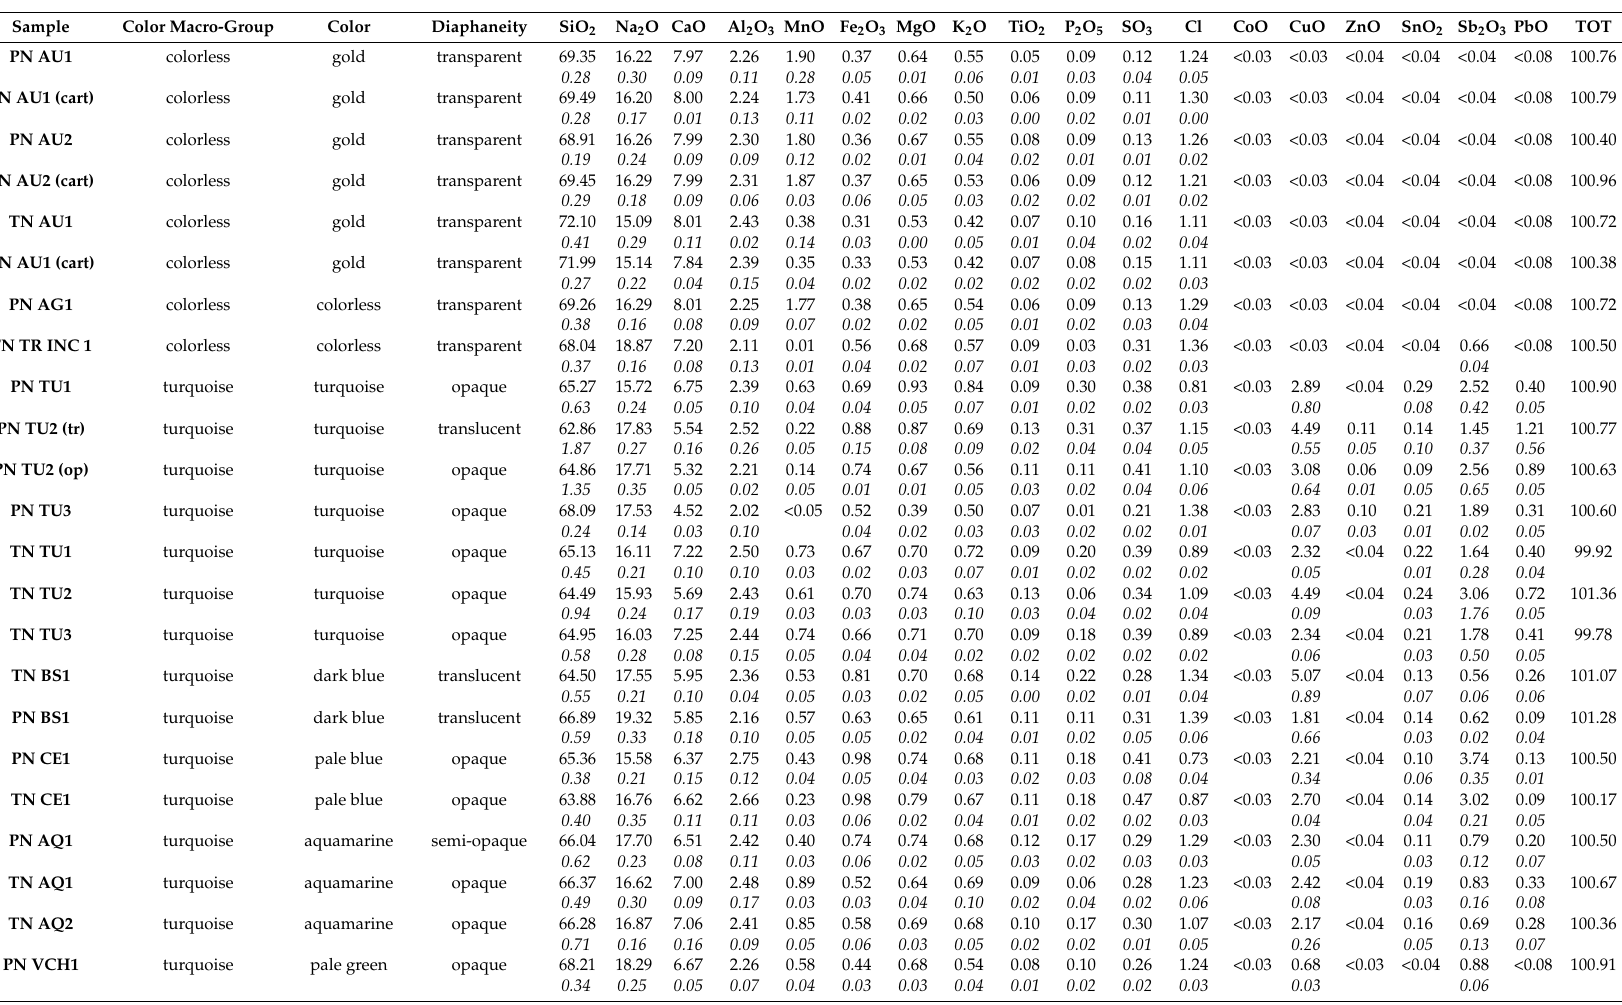
Table 2. The mean chemical compositions of the glass tesserae (EPMA data, expressed as weight percentage of the corresponding oxide, except for chlorine; standard deviation in italics). Color macro-group, color, diaphaneity reported for each